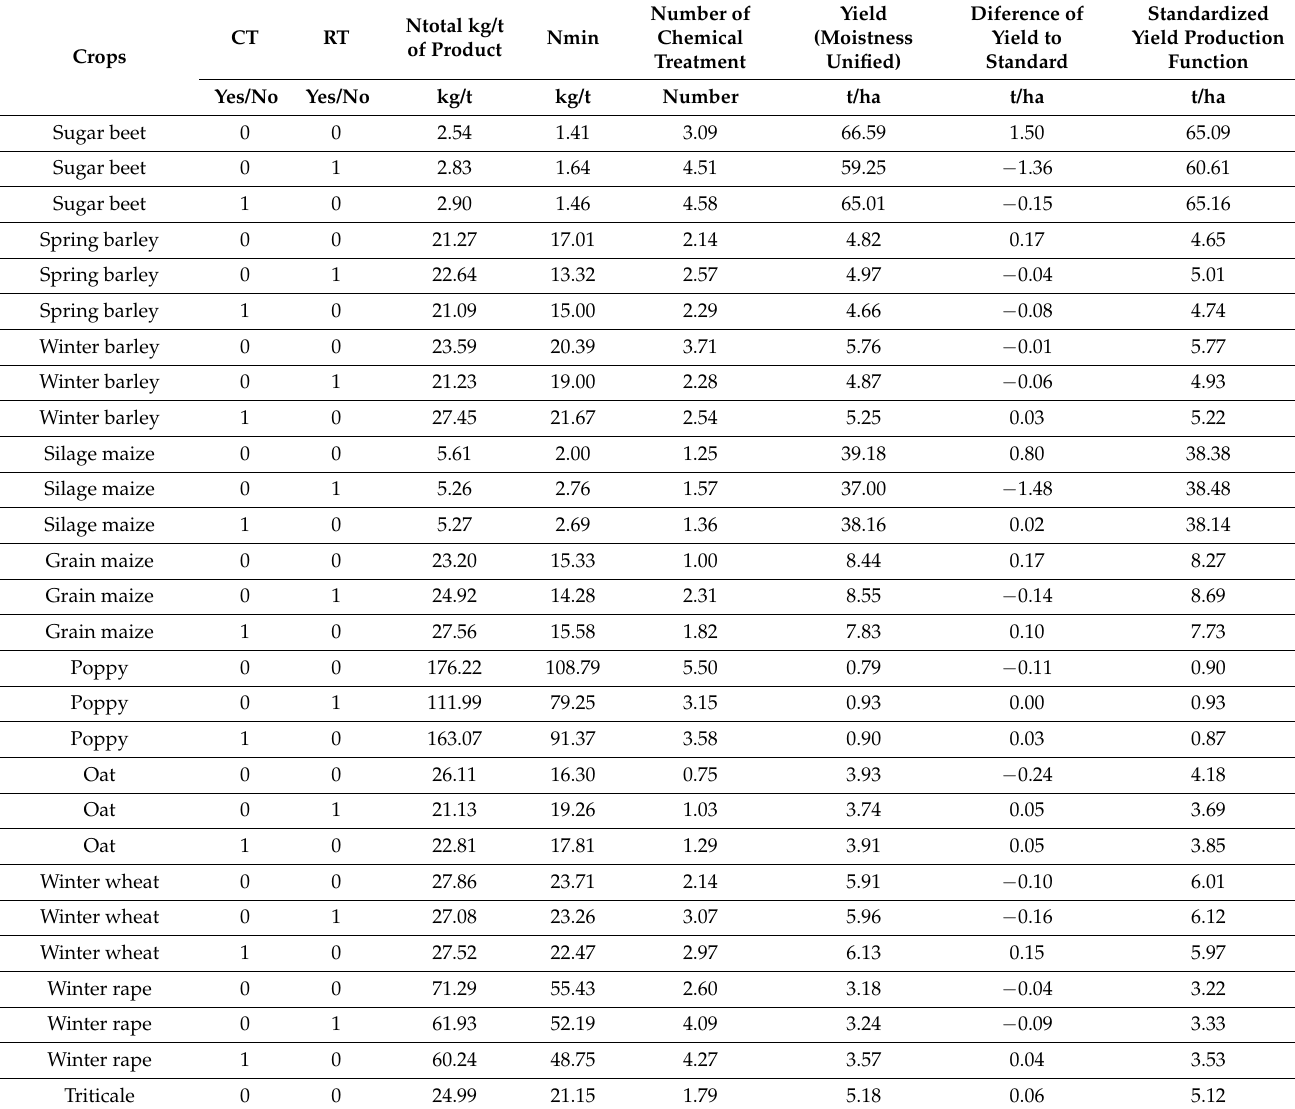
Table A6. Basic information of crops under